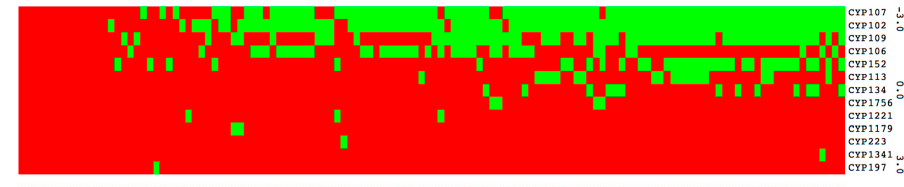
Figure 5. Heatmap of presence or absence of cytochrome P450 families in 128 species of Bacillus . The data have been represented as − 3 for family presence (green) and 3 for family absence (red). A hundred and twenty-eight Bacillus species form the horizontal axis and CYP family numbers form the vertical axis. The respective data used in the generation of Figure 5 is presented in Supplementary Dataset 3.